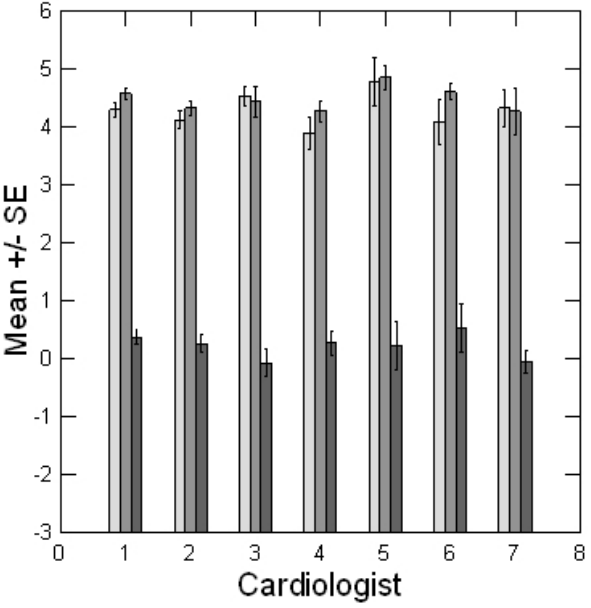
Figure 2. Average ratings of survey items relating to the telehealth (light grey bars) versus in-person experience (medium grey bars) by cardiologist. Dark grey bars represent the paired difference in